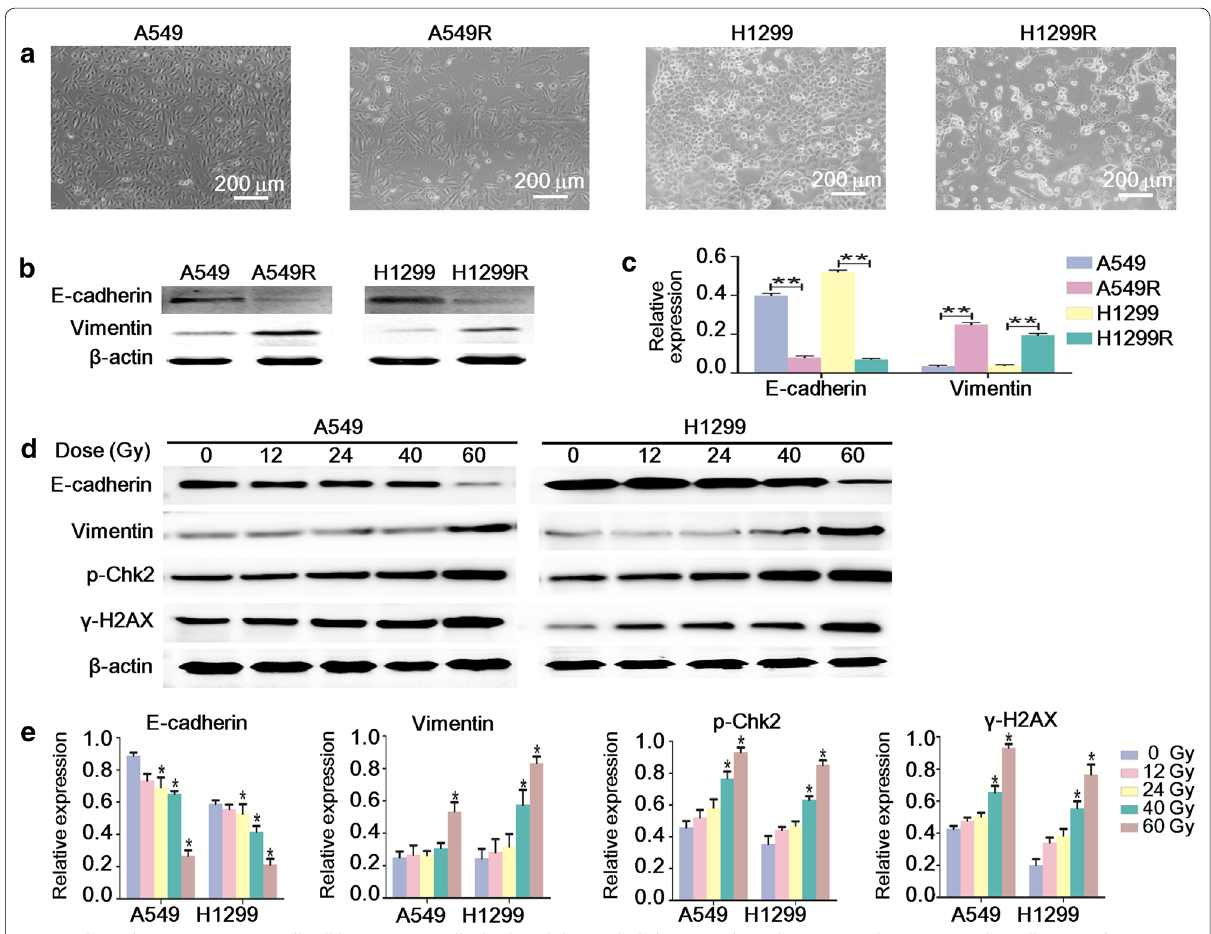
Fig. 2 The radioresistant non‑small cell lung cancer cells displayed the epithelial–mesenchymal transition phenotype. a The cells were photo‑ graphed by light microscope at 100 magnification. b Western blot analysis of E‑cadherin and vimentin expression in A549, A549R, H1299, and × H1299R cells. c The quantification of the protein levels in b ** P < 0.01 (Student’s t test). d Western blot analysis of the dynamic change of the protein levels of E‑cadherin, vimentin, phosphor‑Chk2 (p‑Chk2), and γ‑H2AX during the accumulation of the radiation dose. e The quantification of the protein levels in d . * P < 0.05 (ANOVA‑SNK‑q ′ ) versus the respective 0‑Gy